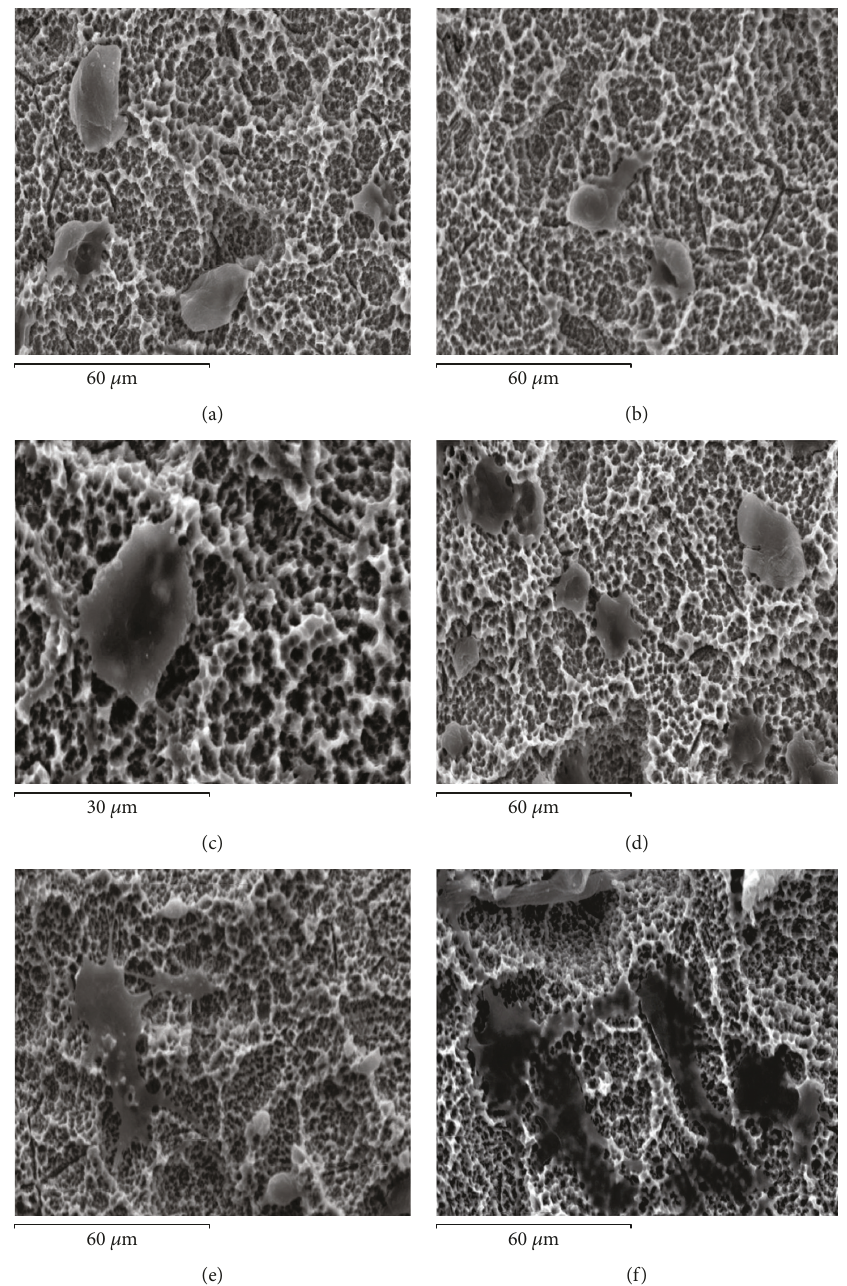
Figure 3: Morphological adaptation in MSCs on the SLA Ti surface. (a) At 5 min, cells appear round with membranous extensions emanating across the rough topography. At (b) 15 min and (c) 30 min, cells appear constrained. At (d) 1 h, cells displayed a slight shift from their previous circular form. At (e) 3 h, cells had adapted a stretched asymmetric morphology that progressed till (f) 24